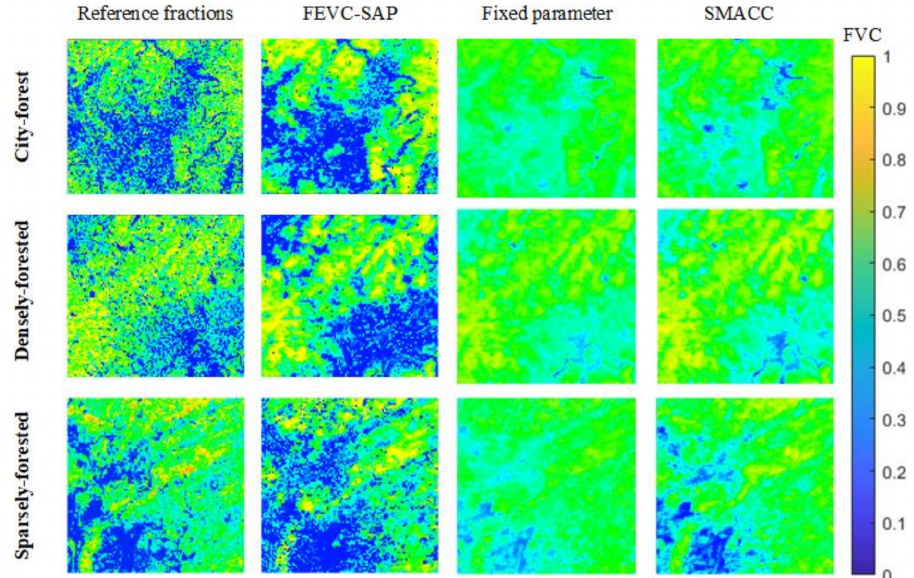
Figure 9. Evergreen forest fractions for three different sites (urban forest, urban area, and a region containing their border) generated using the FEVC-SAP model, the fixed-parameter method, and SMACC. The reference fractions were derived from GF-1 images taken in winter. Fractions range from 0 (blue) to 1